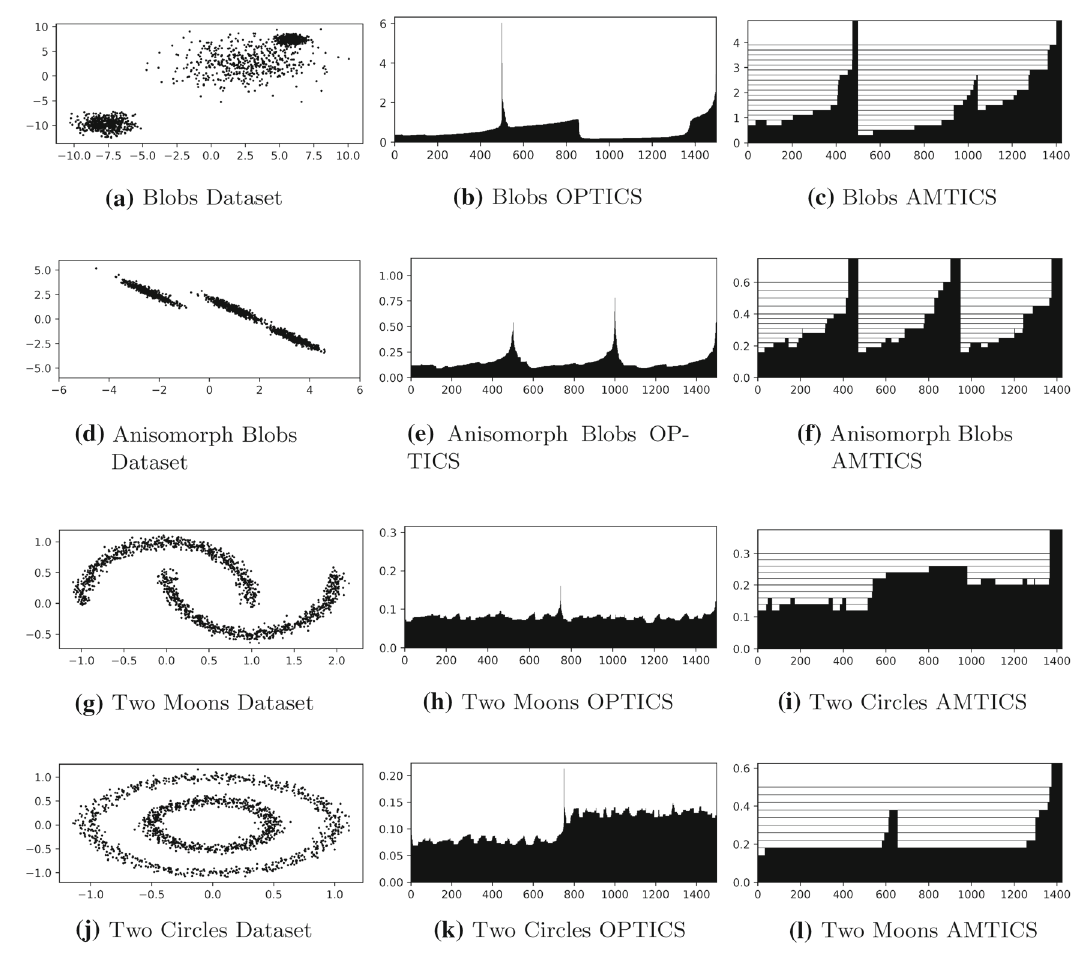
Fig. 8 OPTICS and AMTICS in comparison on different synthetic datasets